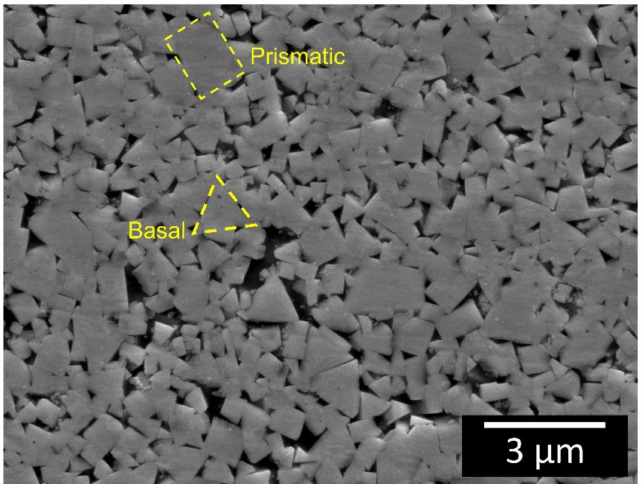
Figure 8. FESEM cross-sectional view of the composite base microstructure after chemo-mechanical polishing. The yellow dashed regions indicate prismatic- and basal-oriented WC